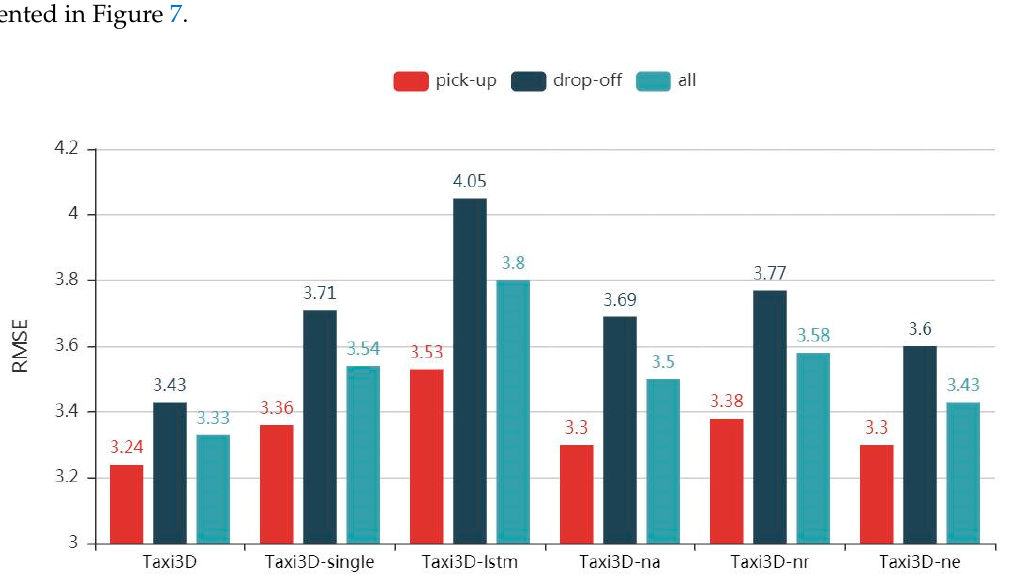
Figure 7. Performance comparison among di ff erent Figure 7 . Performance comparison among different variants.